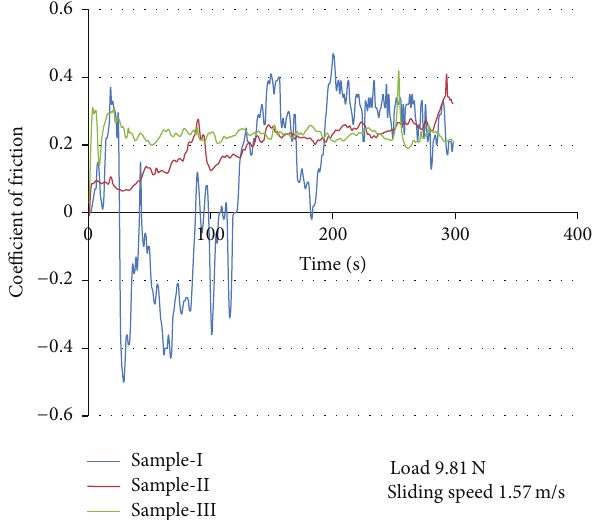
Figure 8: Variation of coefficient of friction with time.